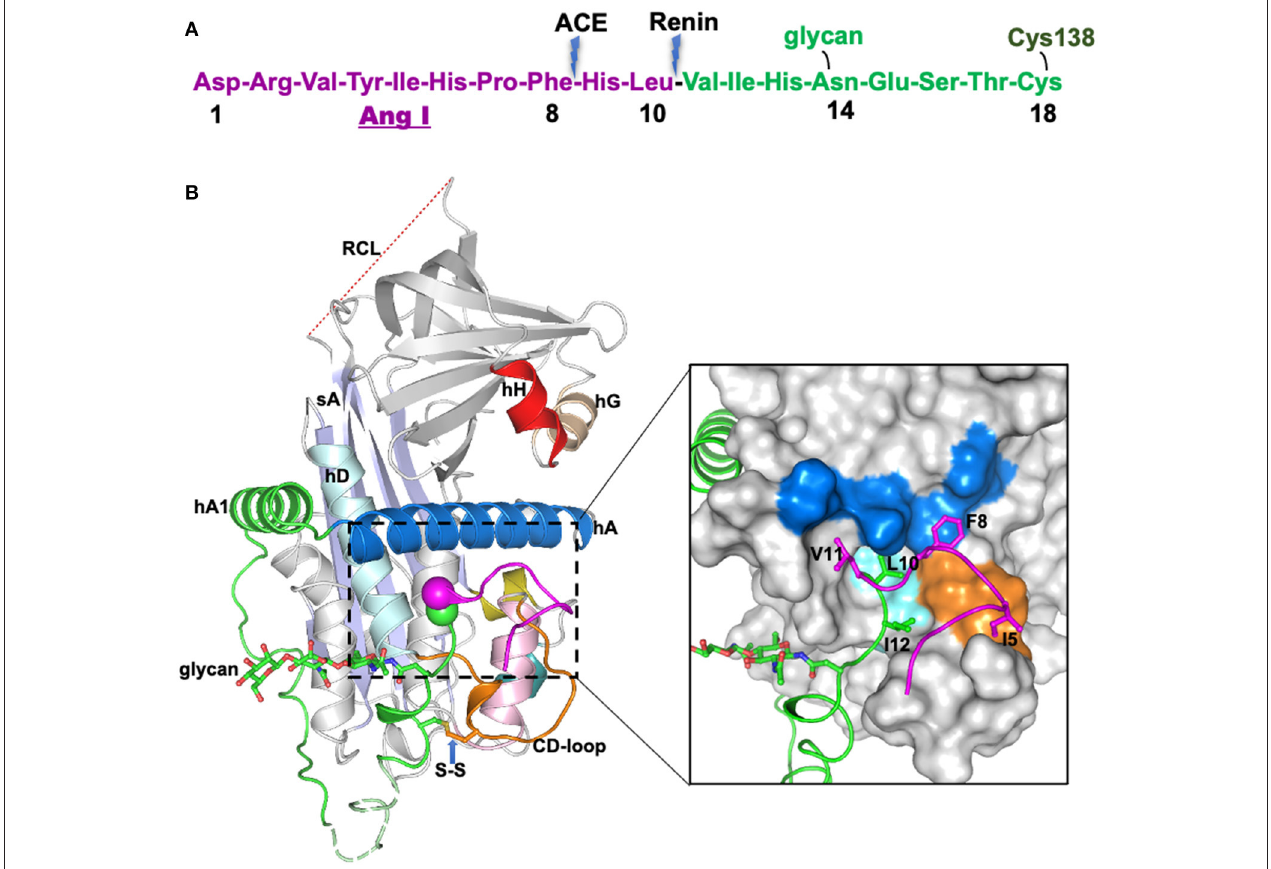
FIGURE 1 | The crystal structure of human glycosylated angiotensinogen (9). (A) N-terminal tail sequence, indicating renin and ACE (angiotensin converting enzyme) cleavage sites, the glycosylation site and conserved disulfide bond. (B) Structure of angiotensinogen shown as a cartoon. Serpin template in gray, helix A in marine, A-sheet light blue, and the disordered reactive center loop (RCL) in red dashes. Angiotensin-I tail in green with the scissile bond shown as magenta and green spheres. Cys18 in the amino tail forms a disulfide bond with Cys138 of the CD-loop (brown). The glycan attached to Asn14 is shown as green sticks. The segment from Glu20-Pro29 (dashed, pale green) is disordered in the structure and modeled for illustration. Surface representation of the main body of AGT, with the extra N-terminus (1-63) shown in cartoon representation. The Angiotensin-I peptide is mainly stabilized by hydrophobic interactions with the main body (colored as yellow surface), and the scissile bond (shown as spheres) is buried in the hydrophobic cavity formed by residues in the CD-loop (V131, P132, and W133), helix A (L68, M72, L76, and F79) and helix D (L142 and V147). The figure was adapted from our previous publication ( 9) with